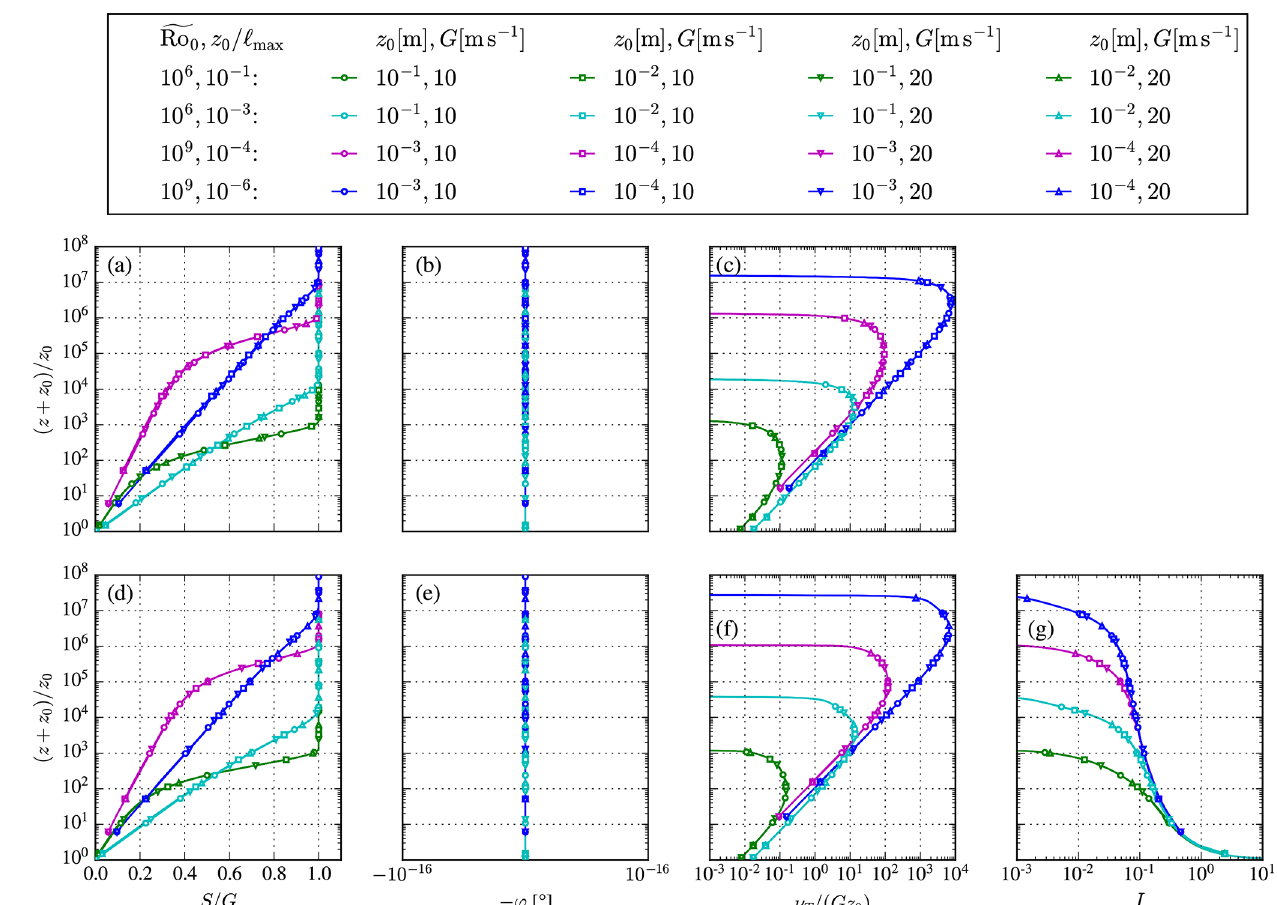
Figure 3. Reynolds number similarity of the proposed ABL model without wind veer for two turbulence closures. (a–c) Mixing-length model. (d–g) k – ε